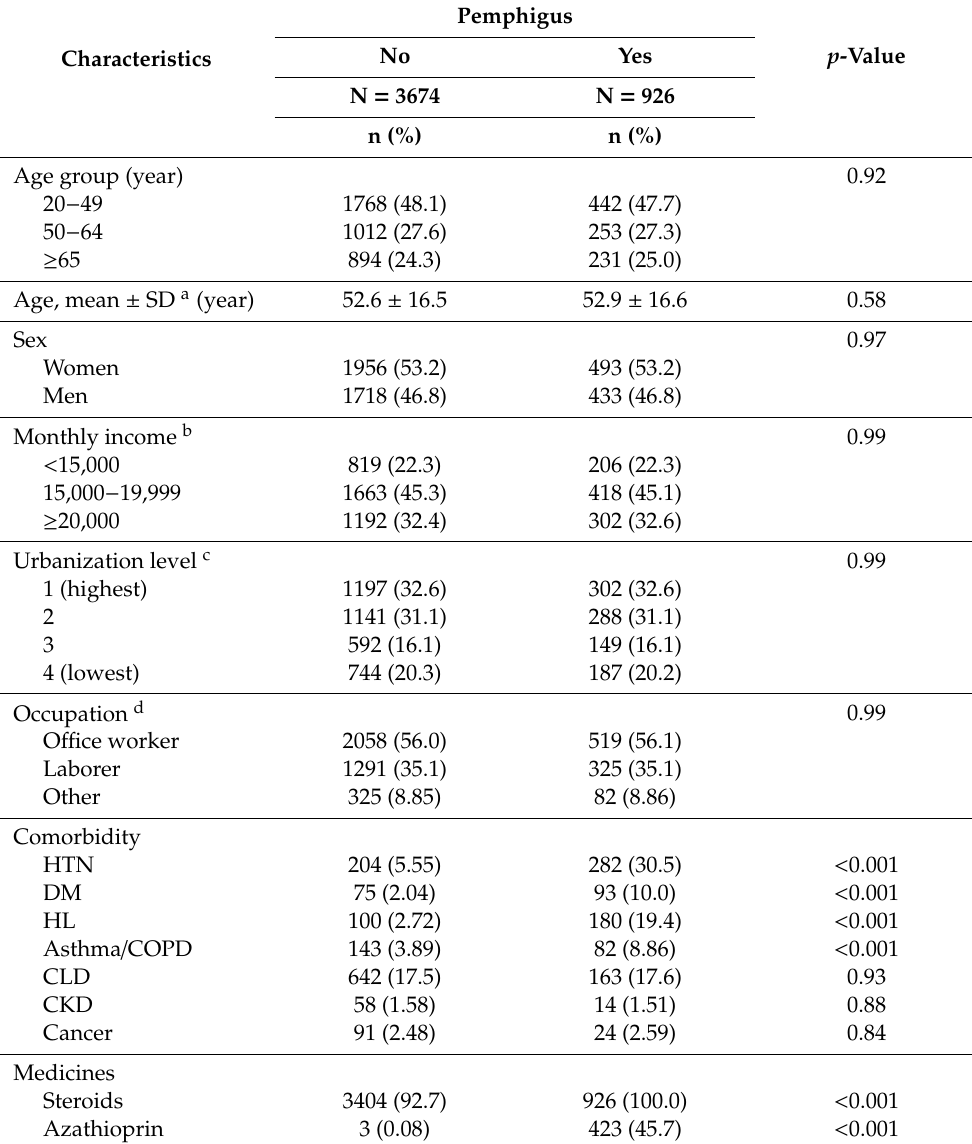
Table 1. Baseline characteristics in individuals with and without